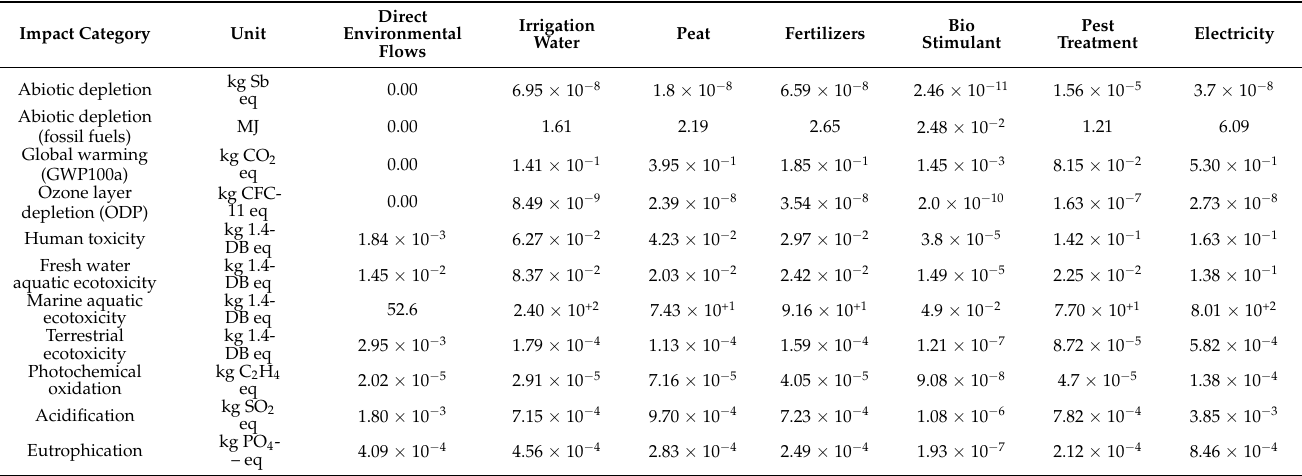
Table 6. S25 Characterization stage of the impacts of 1 kg of lemons for the specified methodology (CML-IA baseline).